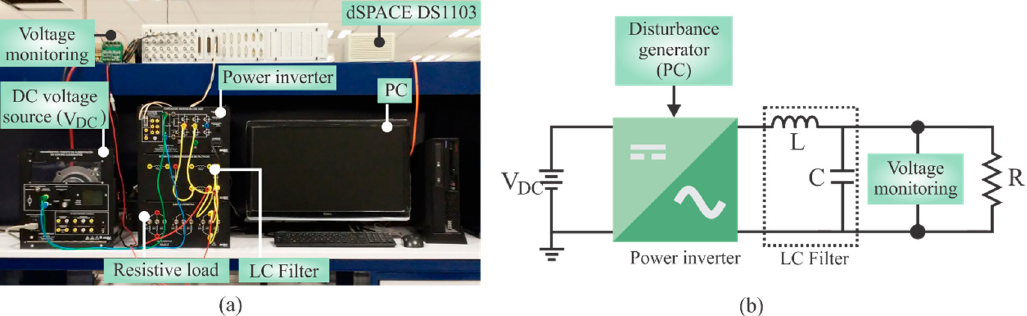
Figure 6. ( a ) Experimental setup and ( b ) electric circuit.